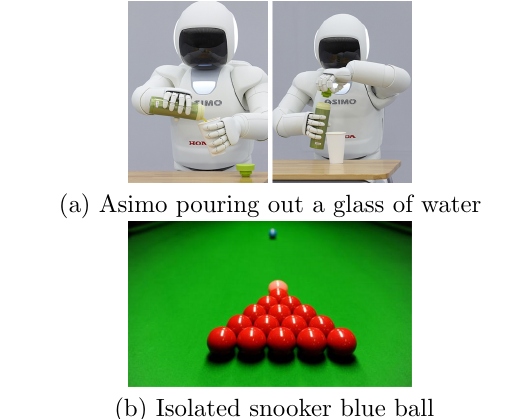
Figure 1. Future robots will have to focus their attention either on close object such a glass of water or farther like the blue